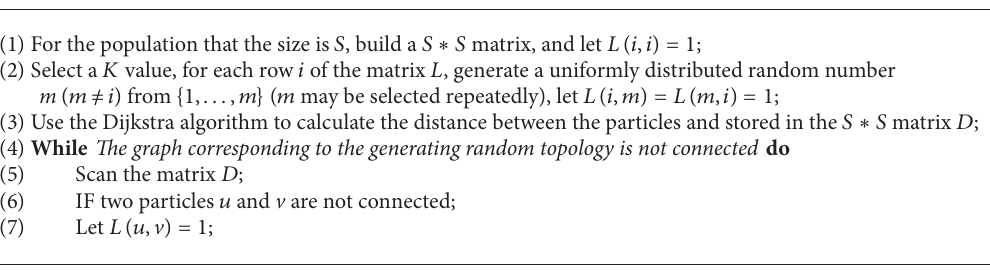
Algorithm 1: Clerc’s generating method of random population topology.